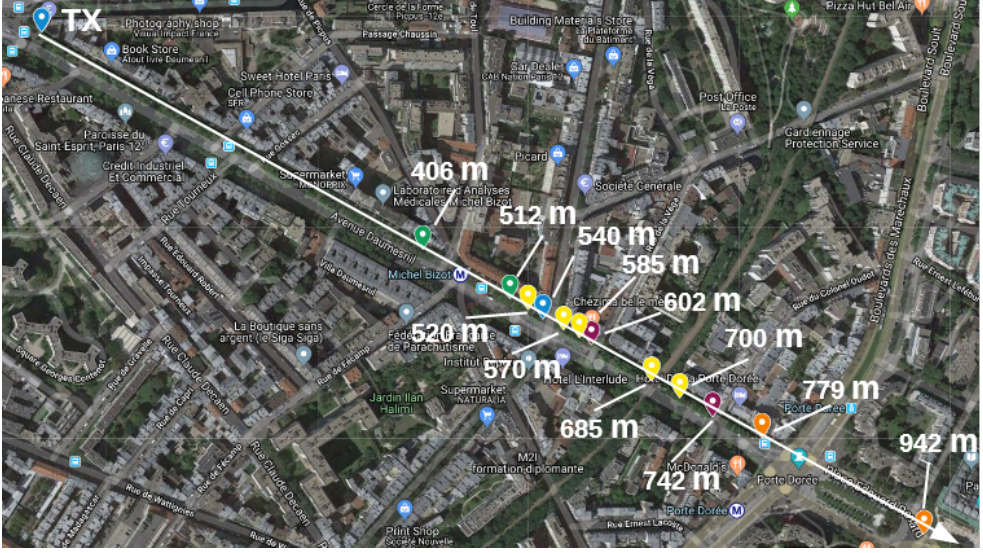
Figure 5. Urban Canyon